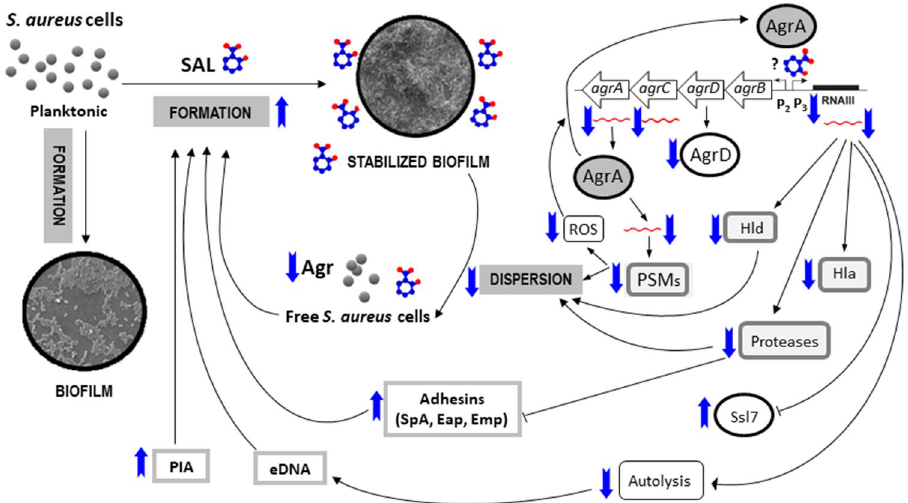
Figure 7. Schematic representation of SAL effects on stabilization of biofilm formed by S. aureus . Summary of changes determined in mRNA or protein expression, biochemical and phenotypic levels. Black lines with arrowheads endings denote stimulation and flat endings inhibition. Up and down blue arrows represent an increased or diminished change induced by SAL,